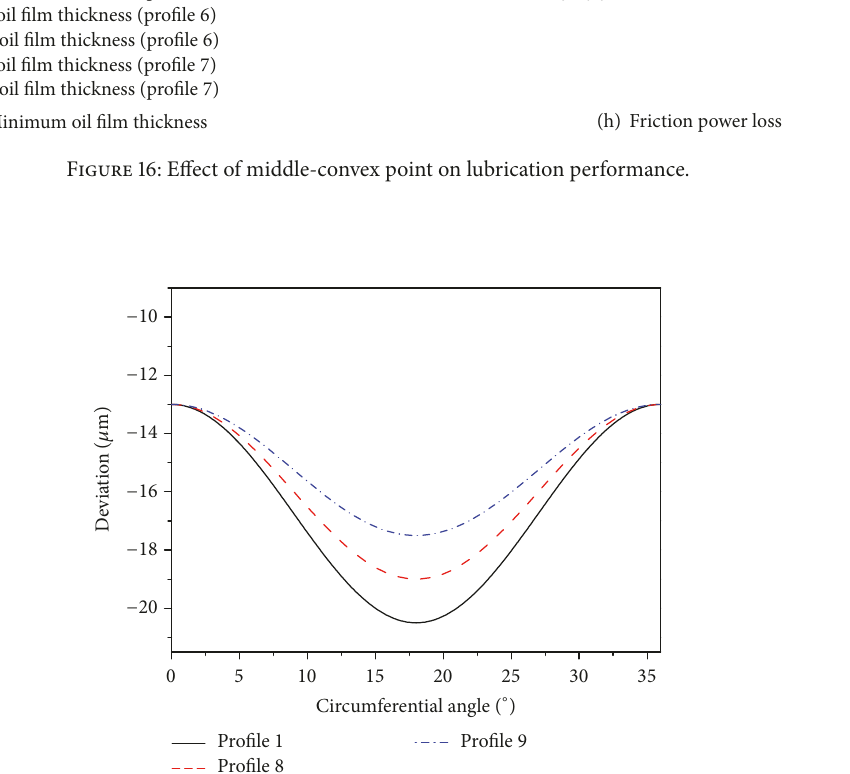
Figure 17: Horizontal profiles of different